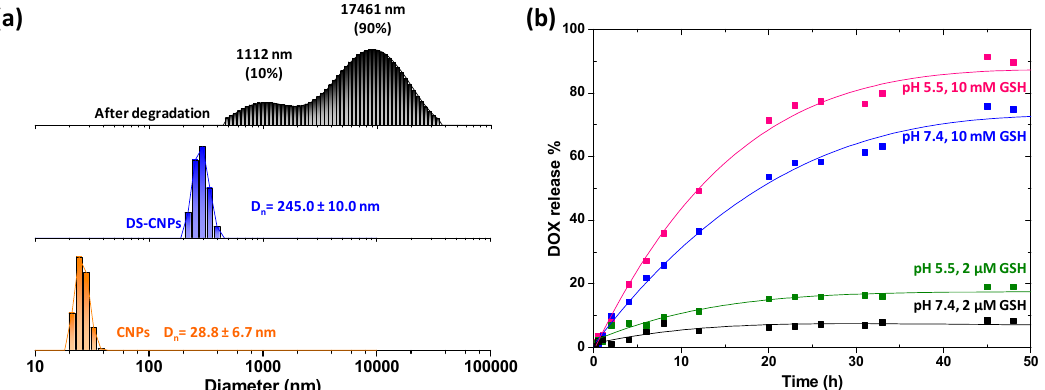
Figure 2. ( a ) DLS diagrams of CNP, DS-CNPs, and degraded DL-CNPs, ( b ) in vitro release profile of DOX from DL-CNPs under various conditions: 10 mM GSH at pH 5.5, 10 mM GSH at pH 7.4, 2 μ M GSH at pH 5.5, and 2 μ M GSH at pH 7.4 as the control.